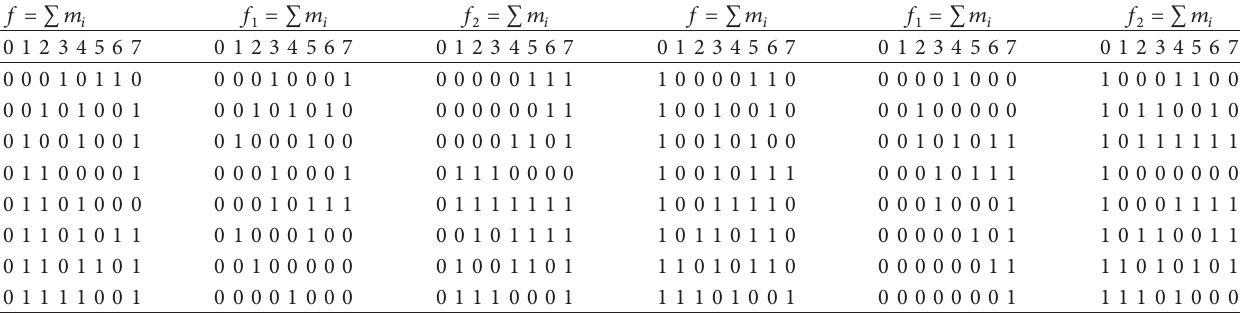
Table 2: The second category of the three-variable nonthreshold functions.